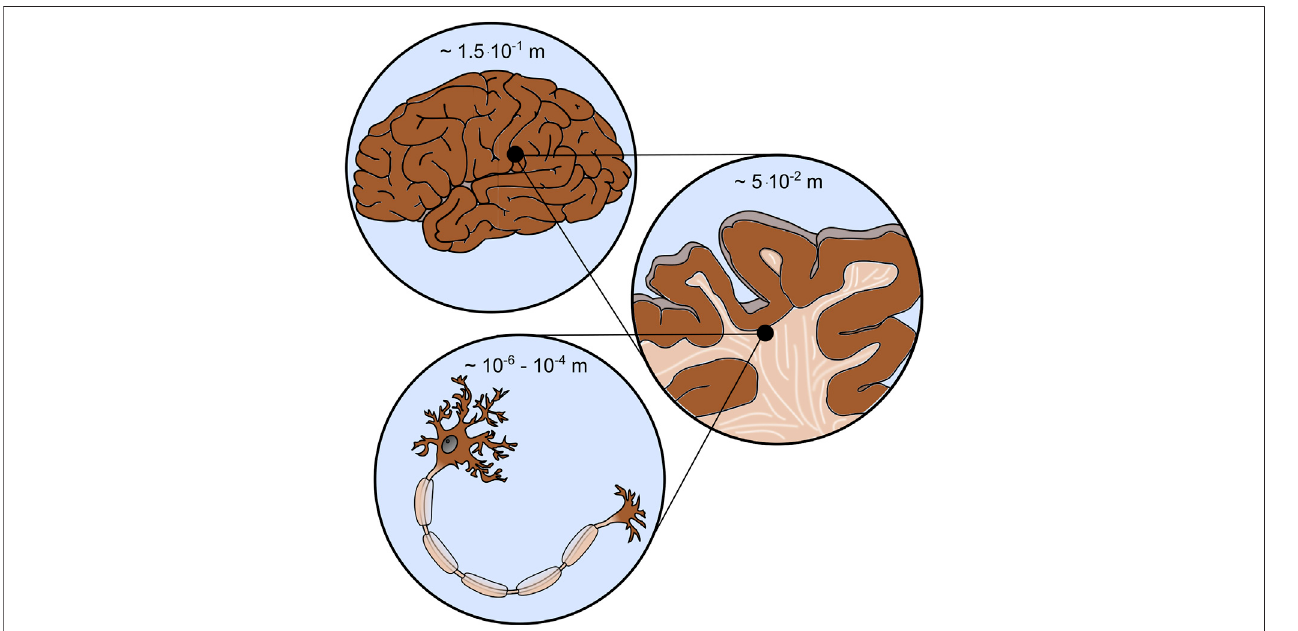
FIGURE 1 | Brain mechanics involves different scales, e.g., the cell (bottom) , tissue (middle) , and organ (top) scale.